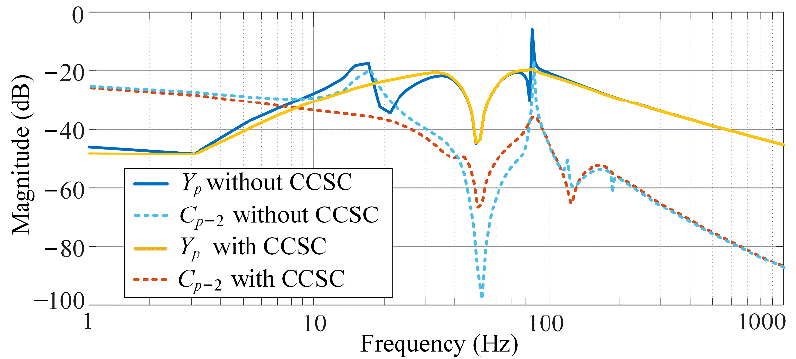
Figure 14. Bode diagrams of MMC admittances with and without CCSC.